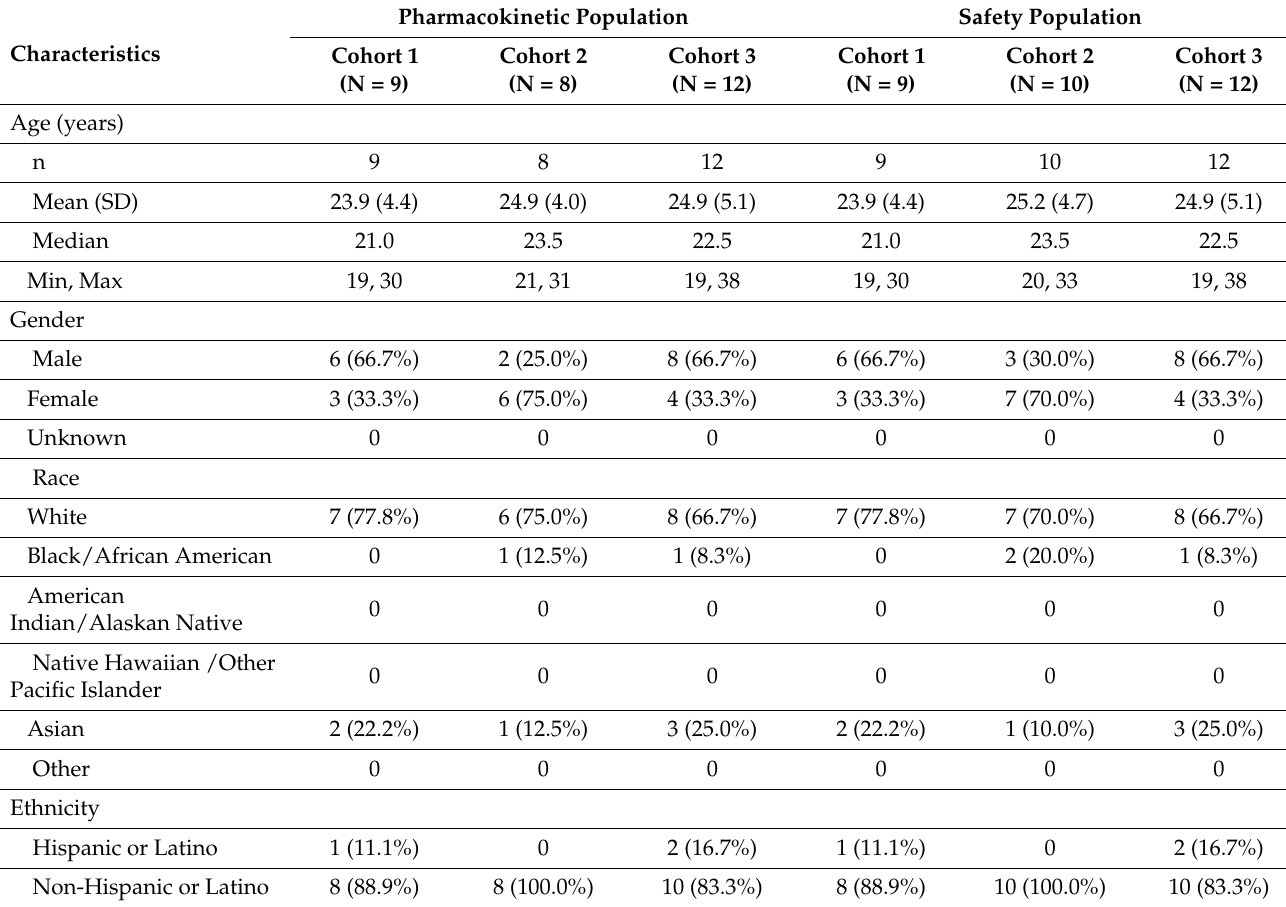
Table 2. Pharmacokinetic and safety